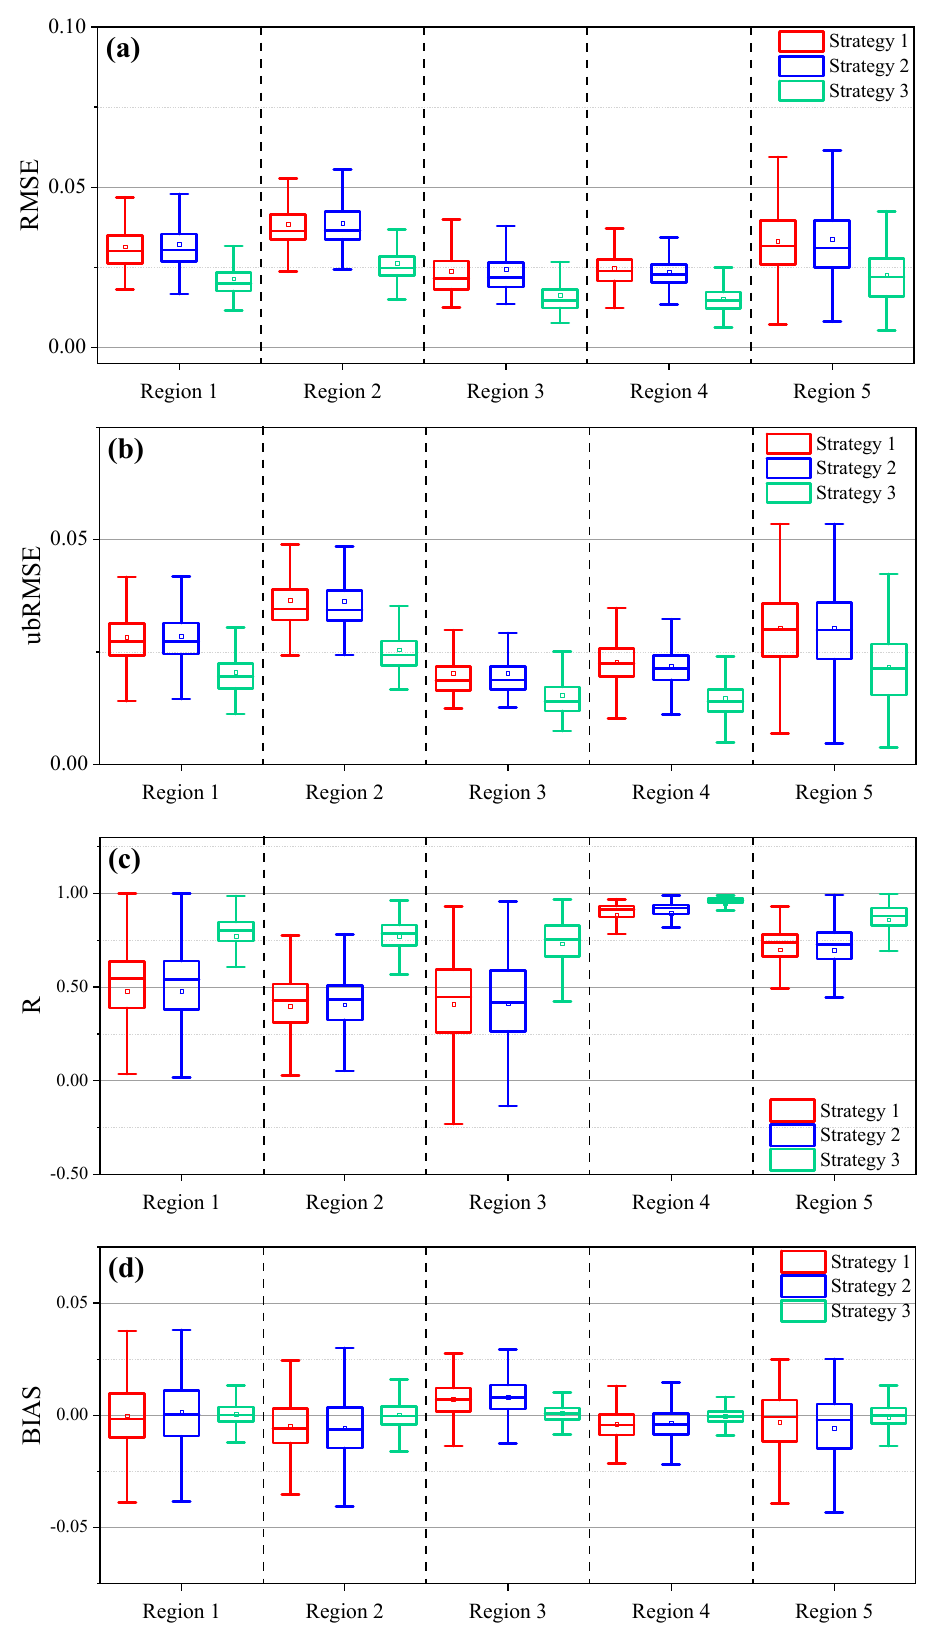
Figure 9. Comparisons of estimated SM by different strategies with the CCI SM over simulated gap areas using ( a ) RMSE, ( b ) ubRMSE, ( c ) R, and ( d ) BIAS.